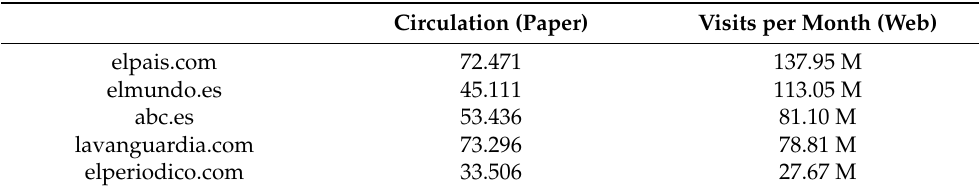
Table 1. Media circulation and visits. Compiled by the authors on the basis of OJD (2020) [43] and Similarweb (2021) [42]